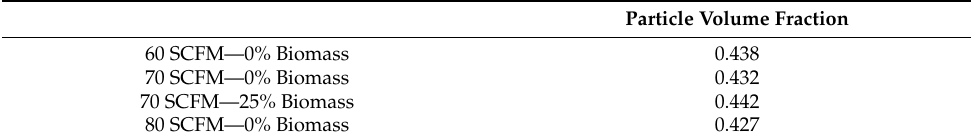
Table 1. Particle volume fractions for the five experimental runs studied. Note: Airflows are given in standard cubic feet per Minute (SCFM).